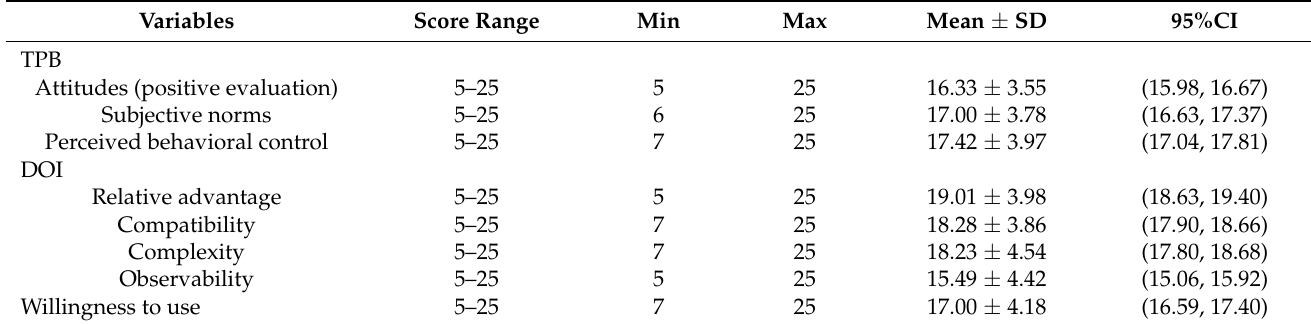
Table 3. Descriptive statistics of variables.